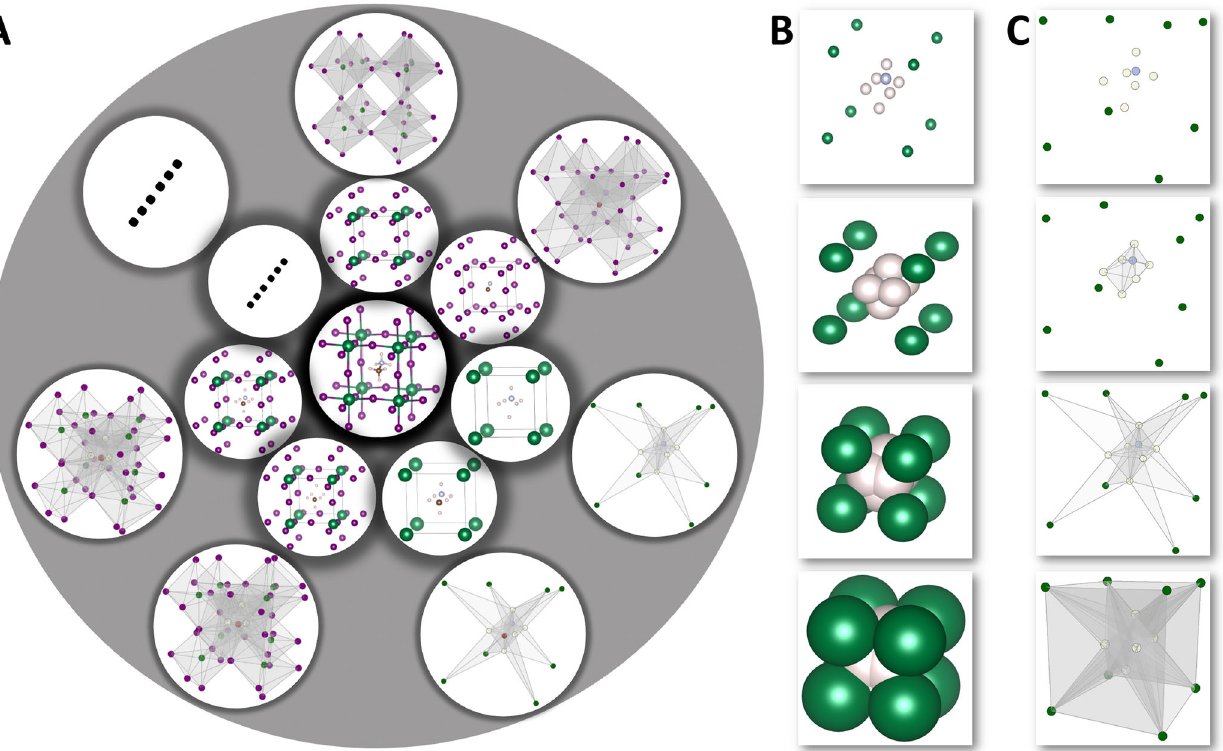
Fig. 2 A multiscale atom-speci fi c representation for OIHP structure. A An illustration of atom-speci fi c representation of OIHP structure. The perovskite supercell is decomposed into a series of atom-sets. B The atom radius is chosen as the fi ltration parameter. The systematically increasing fi ltration value generates a series of topological spaces at different scales. C The corresponding simplicial complexes from the fi ltration